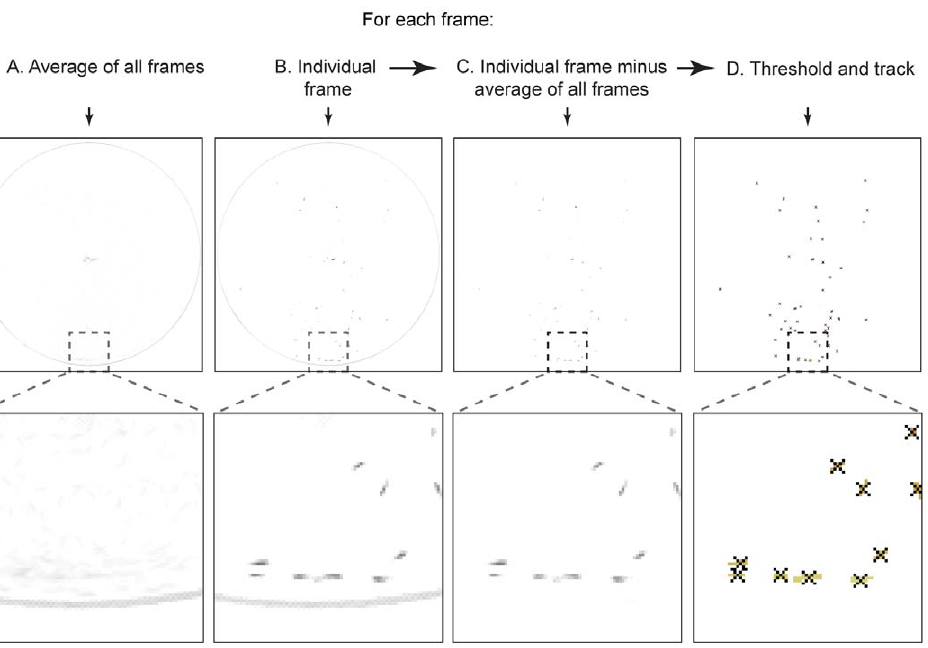
Figure 2. Larvae in the videos were tracked using the Frame Averaging followed by Subtraction then Thresholding method (FAST). We improved video tracking by subtracting individual frames from the average of all frames. The tracking algorithm is as follows: A. For each video, calculate an average of all the frame values. B. Obtain each frame in the video. C. Calculate difference between each frame and the average frame value. D. The result was then analyzed using a binary threshold process. For better visualization the larvae are represented as dark pixels on light background for C and D.